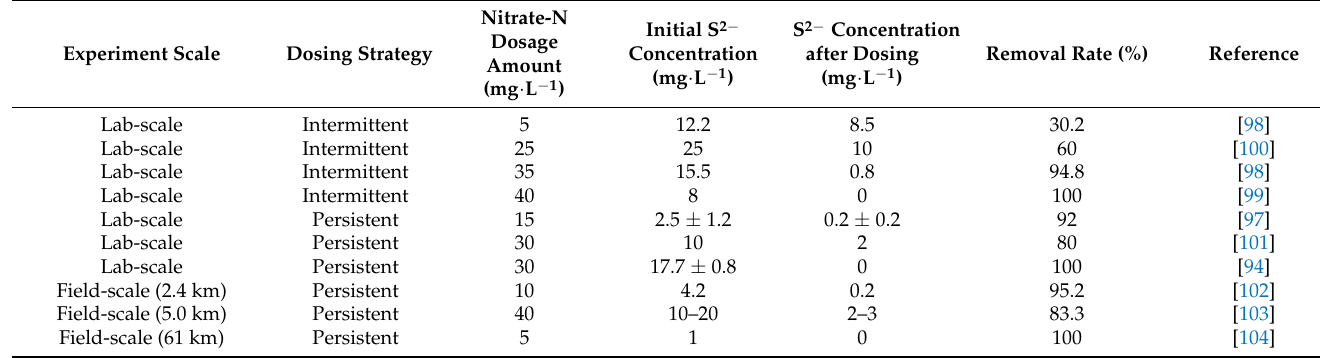
Table 3. Nitrate control parameters and effect